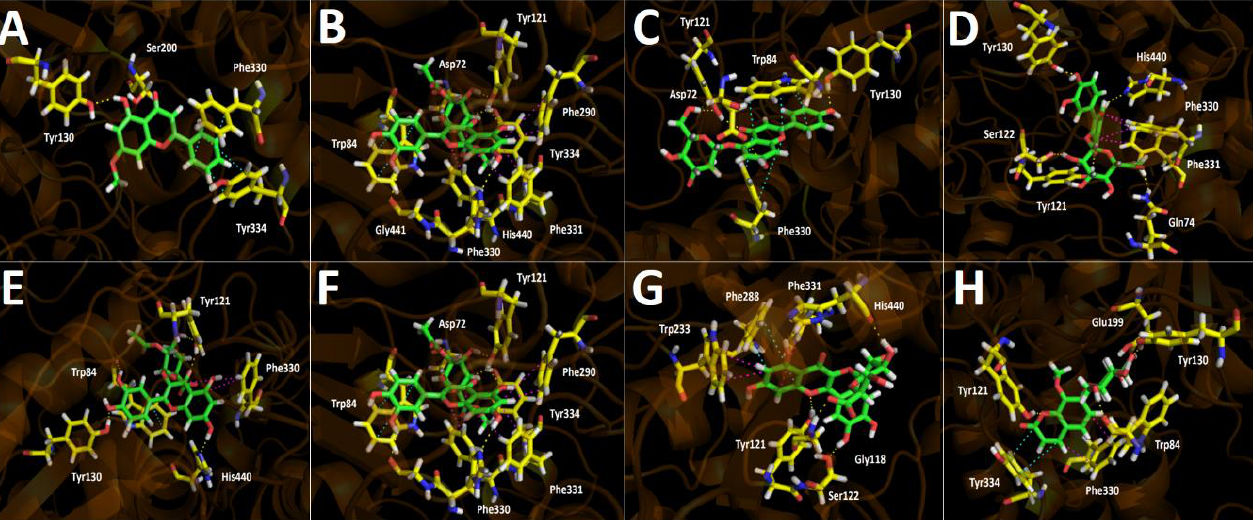
Figure 5. Predicted binding mode and predicted intermolecular interactions of most abundant com- pounds in Ovidia pillopillo leaves extract and the residues of Torpedo Californica acetylcholinesterase ( Tc AChE) catalytic site. Yellow dotted lines indicate hydrogen bond interactions, cyan dotted lines represents π - π interactions, magenta dotted lines represents T -shaped interactions. ( A ). 5-hydroxy-7-methoxy-2-phenyl-4 H -chromen-4-one into the catalytic site; ( B ). Luteolin 7, 4′ -dimethyl ether into the catalytic site; ( C ). Apigenin 5-glucoside into the catalytic site; ( D ). Quercetin 3-O-ß -D-2 ″ -acetylglucuronide into the catalytic site; ( E ). Quercetin 3-O-ß-D-2 ″ -acetylglucuronide methyl ester into the catalytic site; ( F ). Quercetin 3-O-(ß-D-glucuronide) into the catalytic site; ( G ). Quercetin 3-O-ß -D-(glucuronide methyl ester) into the catalytic site; ( H ). 8-O-metyl daphnin, (daphnetin 7 O-glucose, 8-methyl ether) into the catalytic site.